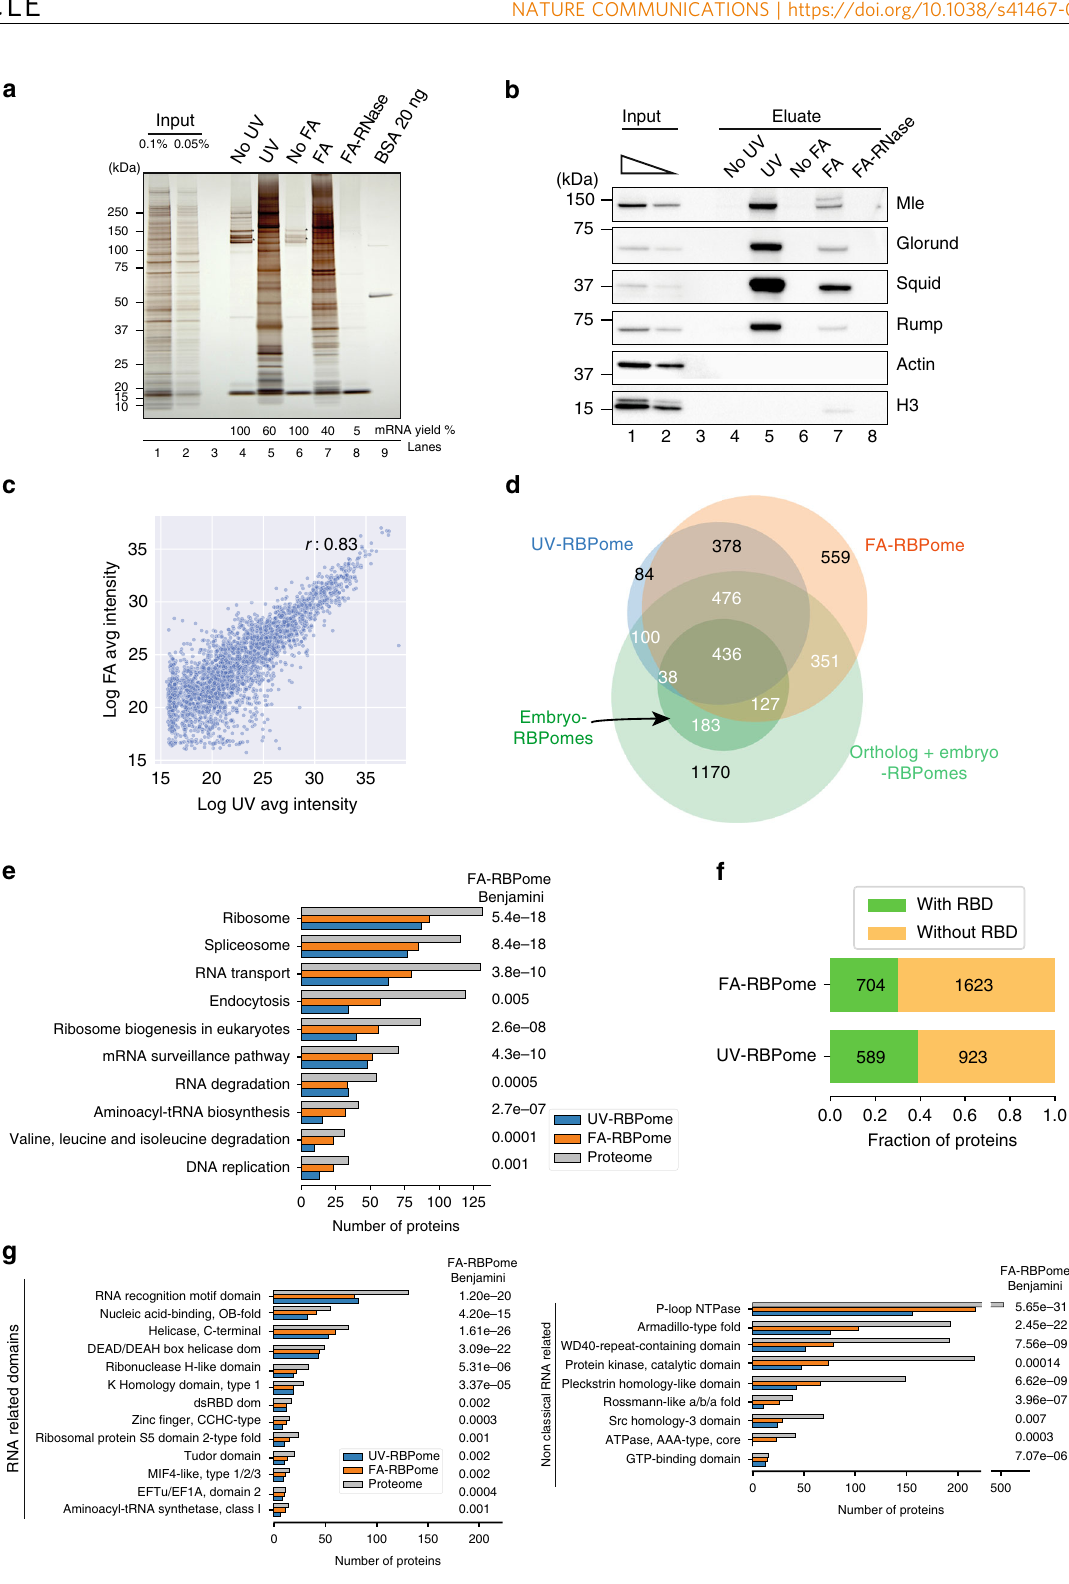
Ribosomal protein S5 domain 2-type fold